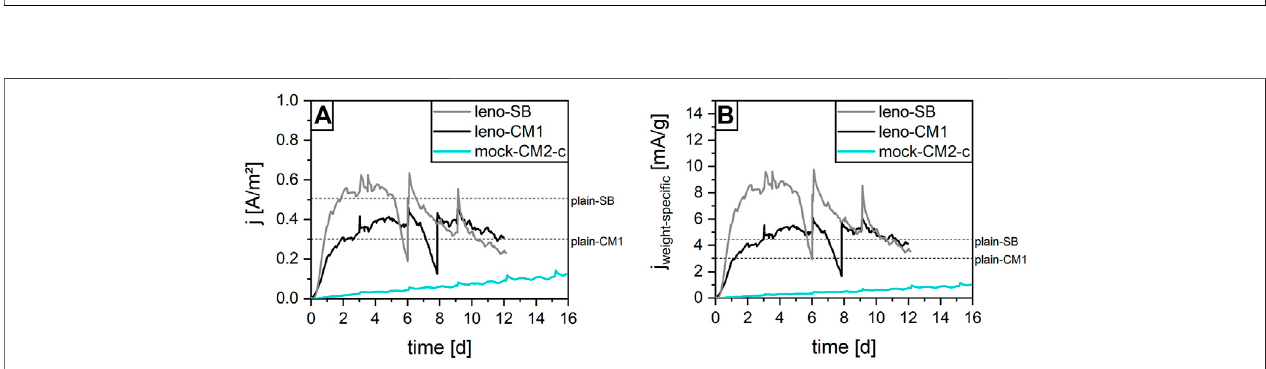
FIGURE 4 | Sublimated Cryo-BIB-SEM images of CF fabric cross-section with S. oneidensis bio fi lms grown in BES. Samples are plain-CM2:12K/2 [ (A) non- fi xed cells; (B) fi xed cells, sputtered with tungsten] and plain-CM2:12k/6 [ (C) , non- fi xed cells]. Fixed cells are visible between carbon fi laments and indicated in (B) . Membranesofnon- fi xedcellswerenotstableandmainlyleftnegative hollowimprints[indicated in (C) ]oronlytheextracellularbio fi lmmatrixwasvisible[indicatedin (A) ]. Scale bars are 4 µm (A) and 2 µm (B,C) .